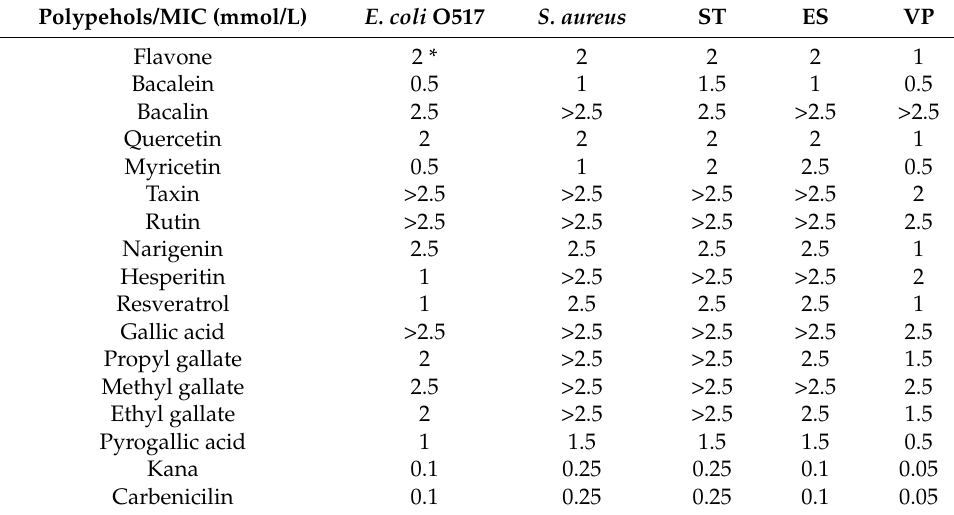
Table 3. Minimum inhibition concentrations of polyphenols on the tested